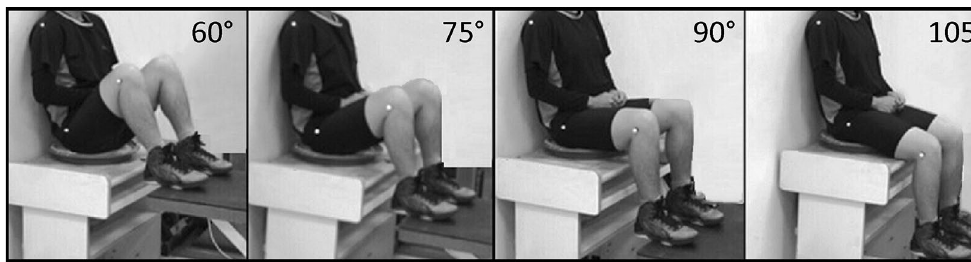
Figure 3. Four varying trunk–thigh angles adopted in the